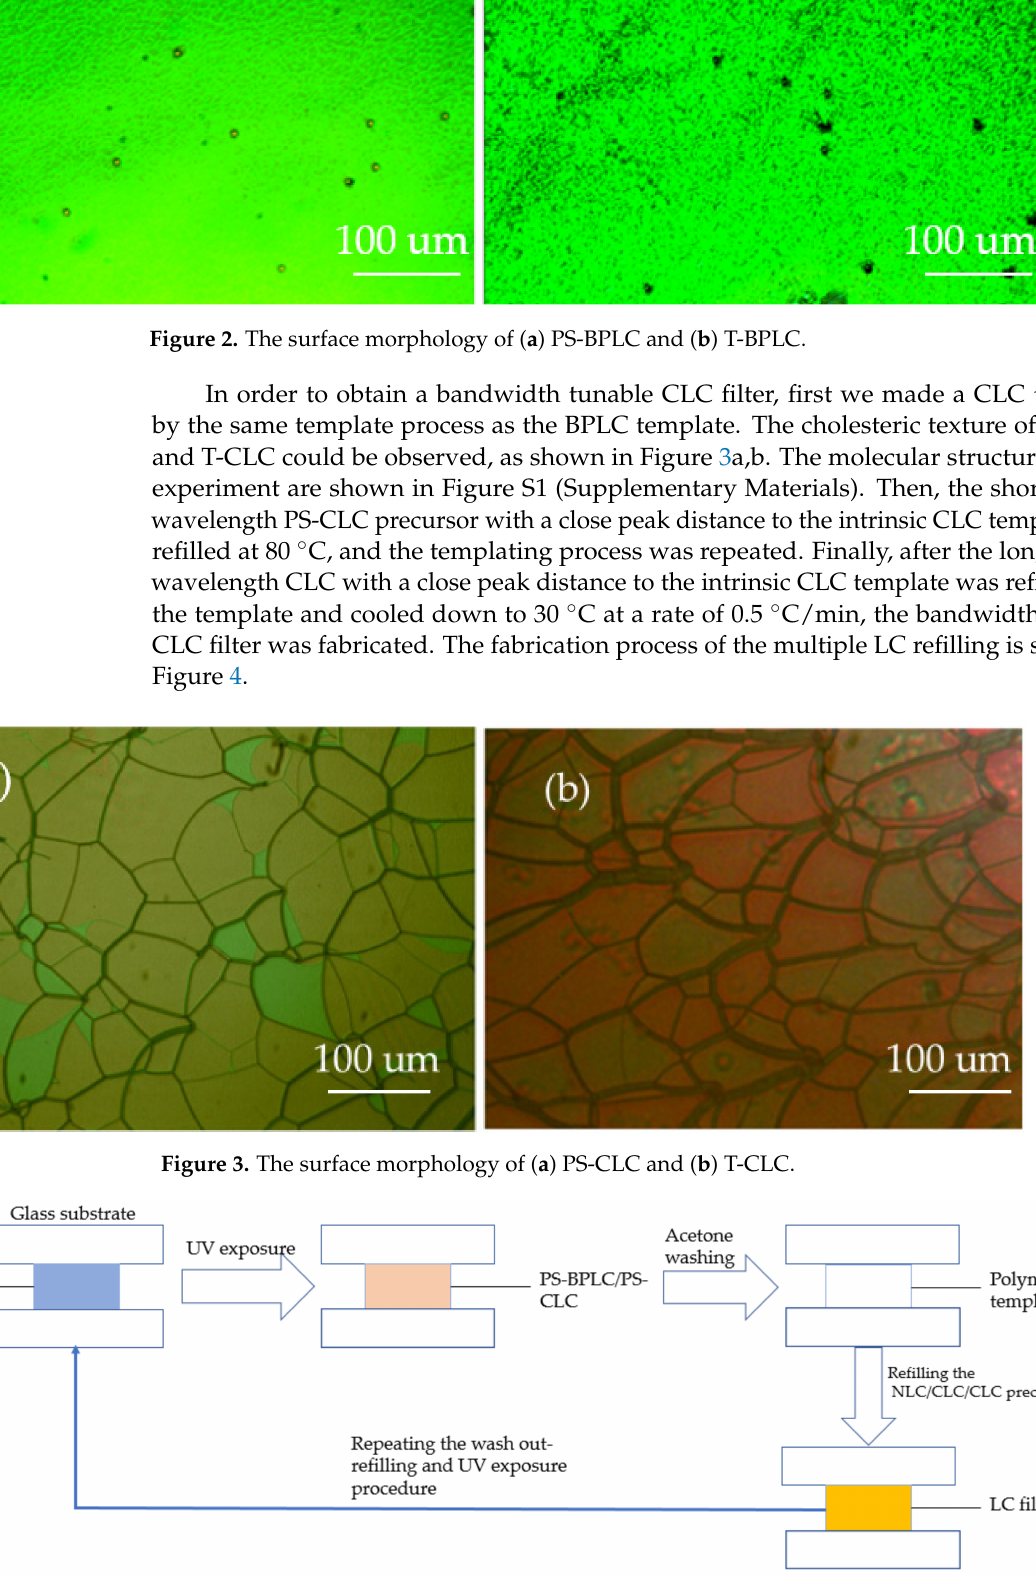
Figure 4. Flow chart of multiple refilling